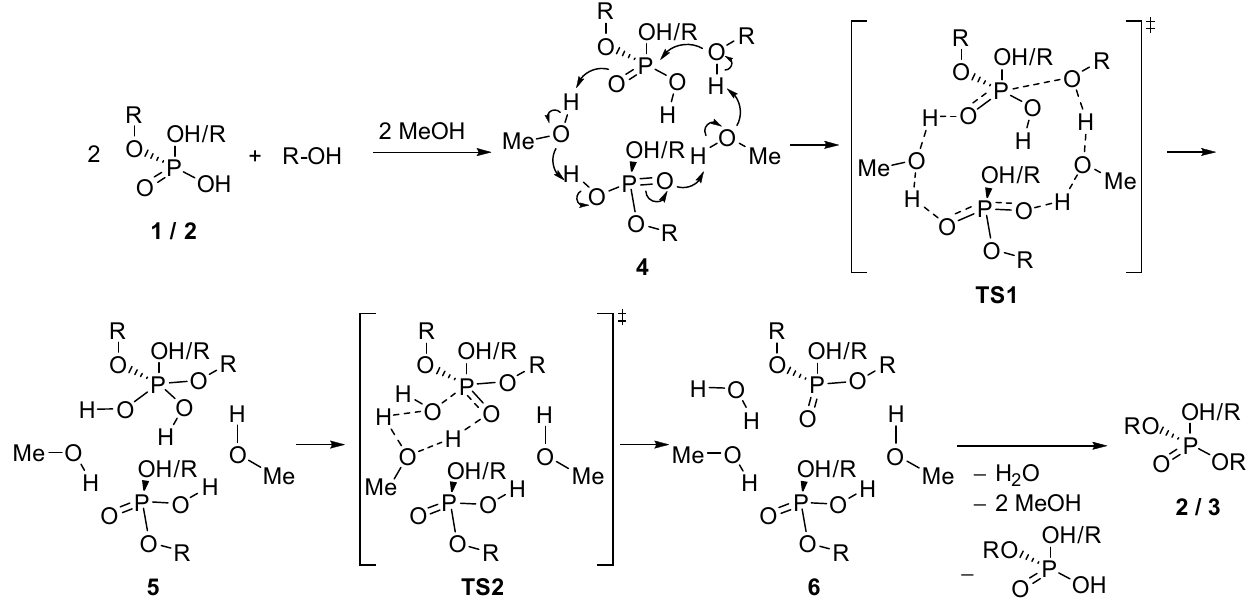
Scheme 2. Plausible reaction mechanism for the monoalkylphosphate → dialkylphosphate → trialkylphosphate transformation. Table 2. Energetics ( ∆ H (kJ mol − 1 )) for the monoalkylphosphate → dialkylphosphate → trialkylphosphate transformations obtained by DFT computations at the M062X/6–311+G (d,p) level of theory considering the solvent effect of the corresponding alcohol.